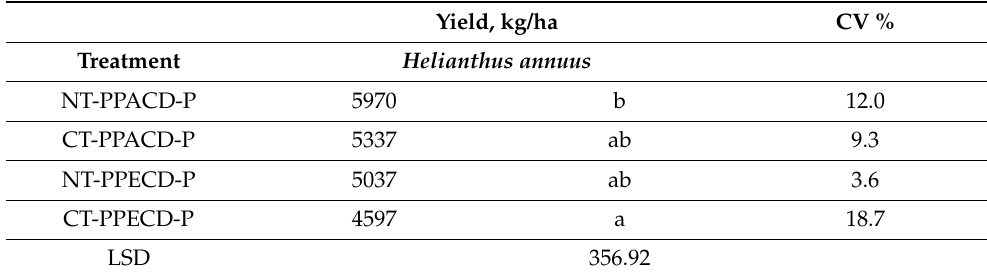
Table 12. Biomass of the Helianthus annuus cultivation (kg ha − 1 ) under different soil practices during the 2nd